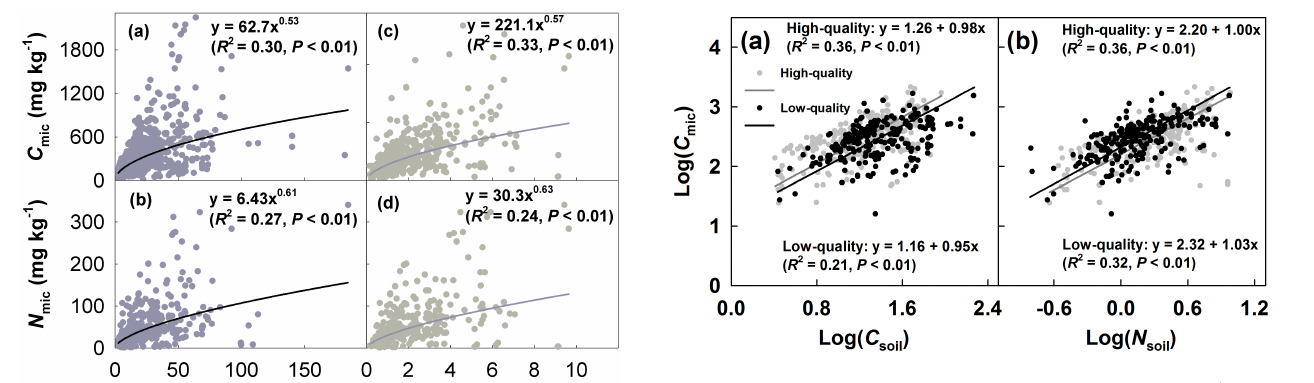
Figure 4. Relationships between microbial biomass carbon (C mic ) and soil organic carbon (C soil , a ), and soil total nitrogen (N soil , b ) by two soil quality groups: high-quality group (C soil :N soil ratio ≤ the median of the whole data set, n = 251) vs. low-quality group (C soil :N soil ratio >the median, n = 250; See details in the Meth- ods). Log stands for 10-based logarithm. The standardized major axis (SMA) models are given for each